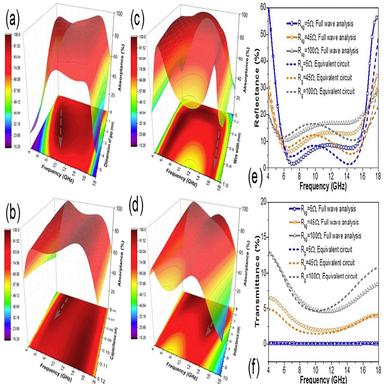
Influences of design parameters on microwave performance in full wave analysis and in equivalent circuit model. (a–d) 3D-representations of frequency dependent absorptance changing along with (a) dimension of gap (p-2d) between each unit, (b) capacitance C, (c) width of wire w, (d) inductance L. (e) Reflectance and (f) transmittance spectra under different values of Rg (dash lines) and surface resistance of bottom ITO film Rsg (hollow dots).